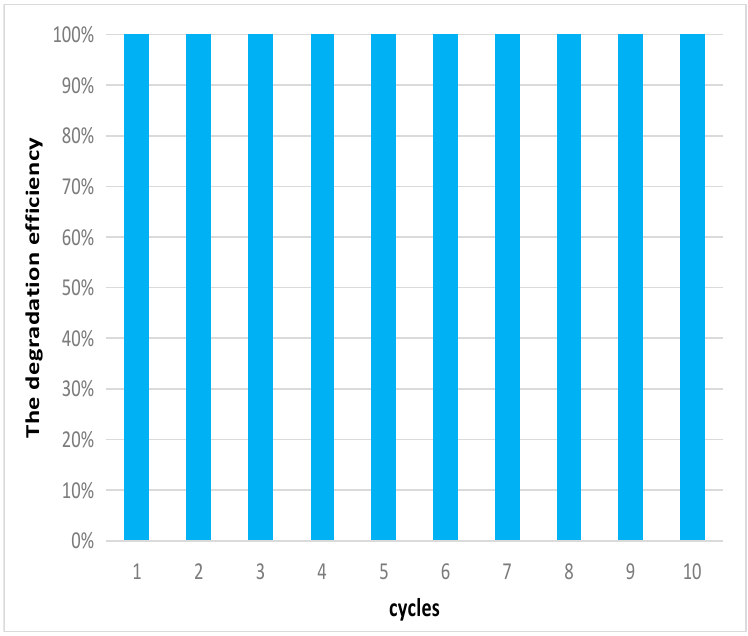
Figure 9. Cyclic degradation of MO by the catalyst of TiO 2 (40%)@CdS under light irradiation with a reaction time of 120 min for each cycle.